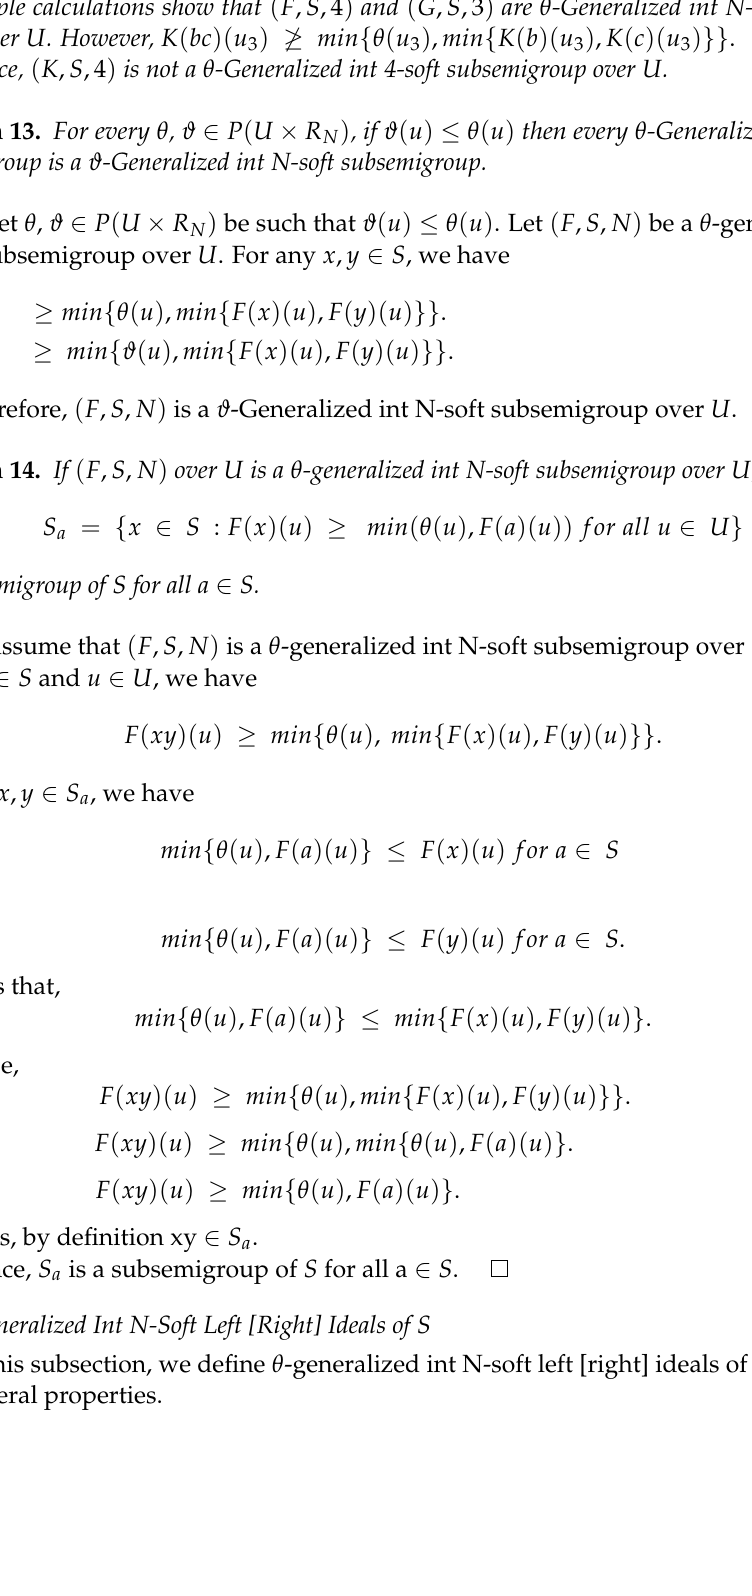
Consider θ = { ( u 1 , 2 ) , ( u 2 , 1 ) , ( u 3 , 2 ) }